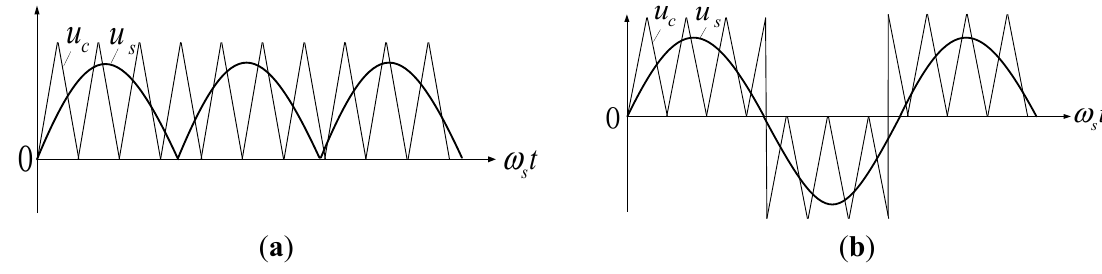
Figure 13. Modulation mode equivalent transformation of BSS-FBC and single-phase PWM converter with unipolar control: ( a ) PWM modulation mode of BSS-FBC; ( b ) Unipolar modulation of single-phase PWM